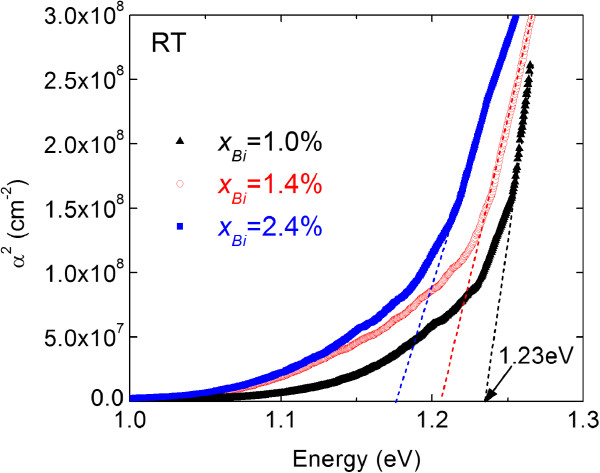
Square of absorption coefficient of InPBi samples. Square of absorption coefficient of InPBi samples with various Bi compositions as a function of photon energy at room temperature.